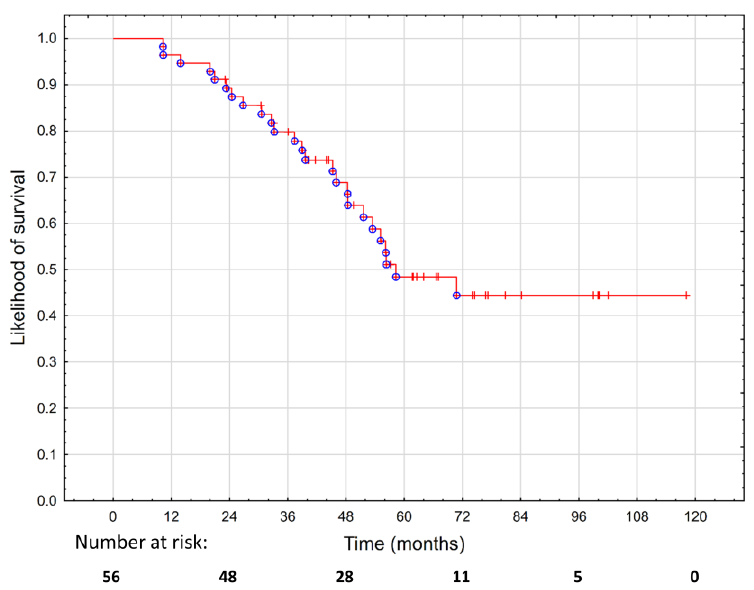
Figure 3. Overall survival in 56 patients treated with hypofractionated salvage re-irradiation for local post-radiotherapy prostate cancer recurrence.